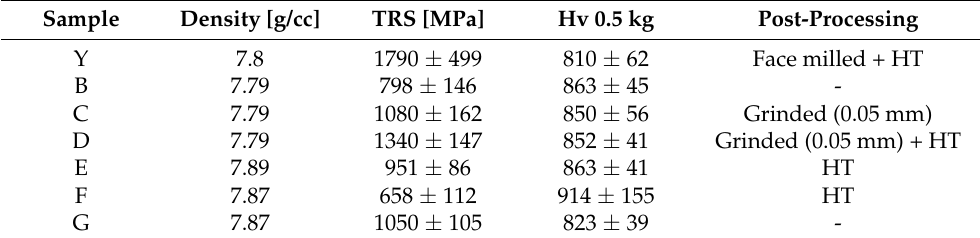
Figure 10. EDS analysis on sample D in the Q + T condition. Table 3. Synoptic table of the mechanical properties of the ESFed samples.